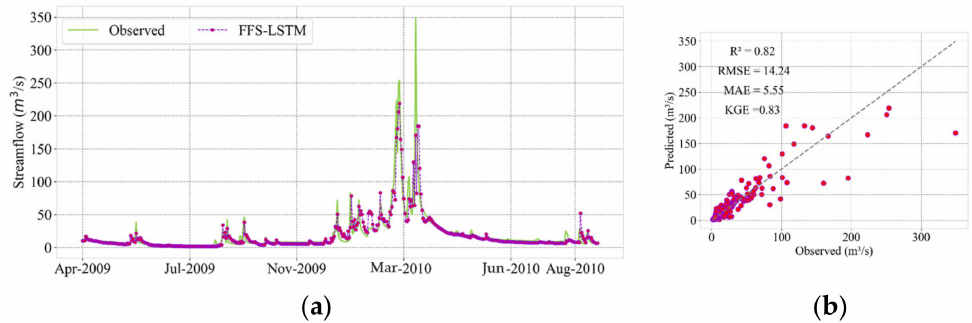
Figure 7. The hydrograph of observed and predicted daily streamflow of FFS-LSTM scenario during the testing ( a ) using approach 1 at TS = 10 along with the corresponding scatter plot ( b ).